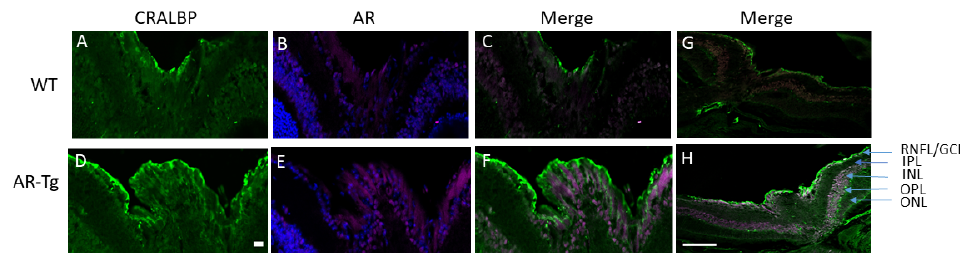
Figure 3. Distribution of AR and cellular retinaldehyde binding protein (CRALBP), a well- characterized marker for Müller glia in WT ( A – C , G ) and AR-Tg ( D – F , H ) mouse eyes. Cryosections of retinal tissue were immunostained for the presence of human AR (magenta) and CRALBP (green) in 24-week-old wild-type control (WT) and age-matched AR-Tg mice. Images of the AR immunostain also showed nuclei identified by DAPI-staining (blue). Panels G and H show full thickness retinal images, where strong CRALBP positivity can be seen in presumptive Müller glia in AR-Tg extending from the RNFL complex to the ONL. Scale bar = 100 µ m. Images are representative of ≥ 3 animals. Labeling of retinal layers is as in Figure 1.